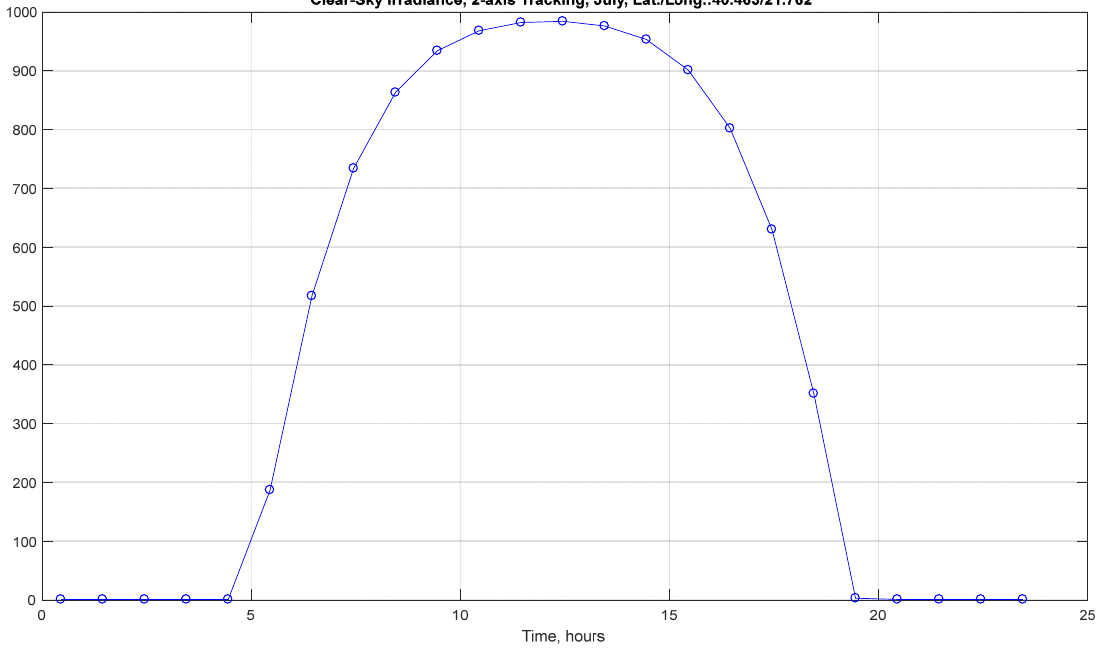
Figure 2. Estimated varying electrical load demands on a 24-h basis. One essential constraint is the power balance, showing that the sum of the output powers